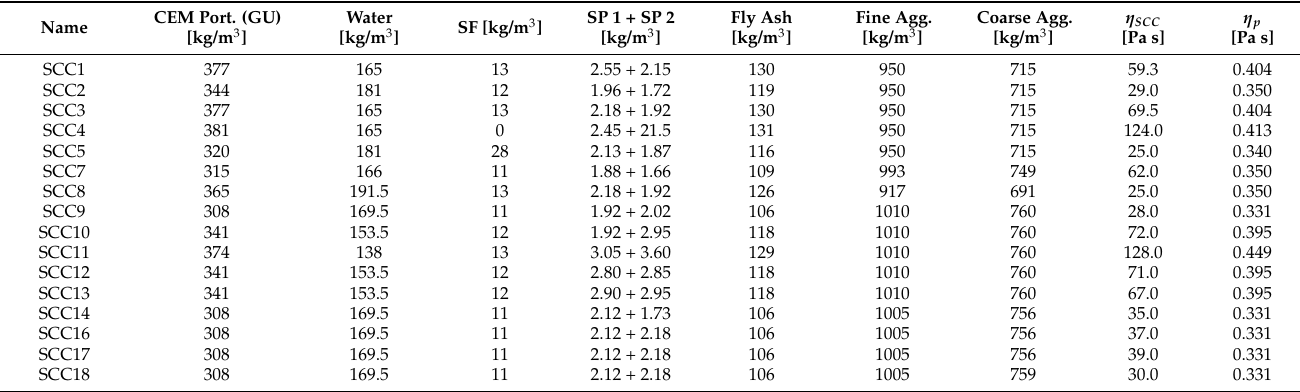
Table A4. Dosages and dynamic viscosities of the self-compacting concretes in Esmaeilkhanian et al. [40].